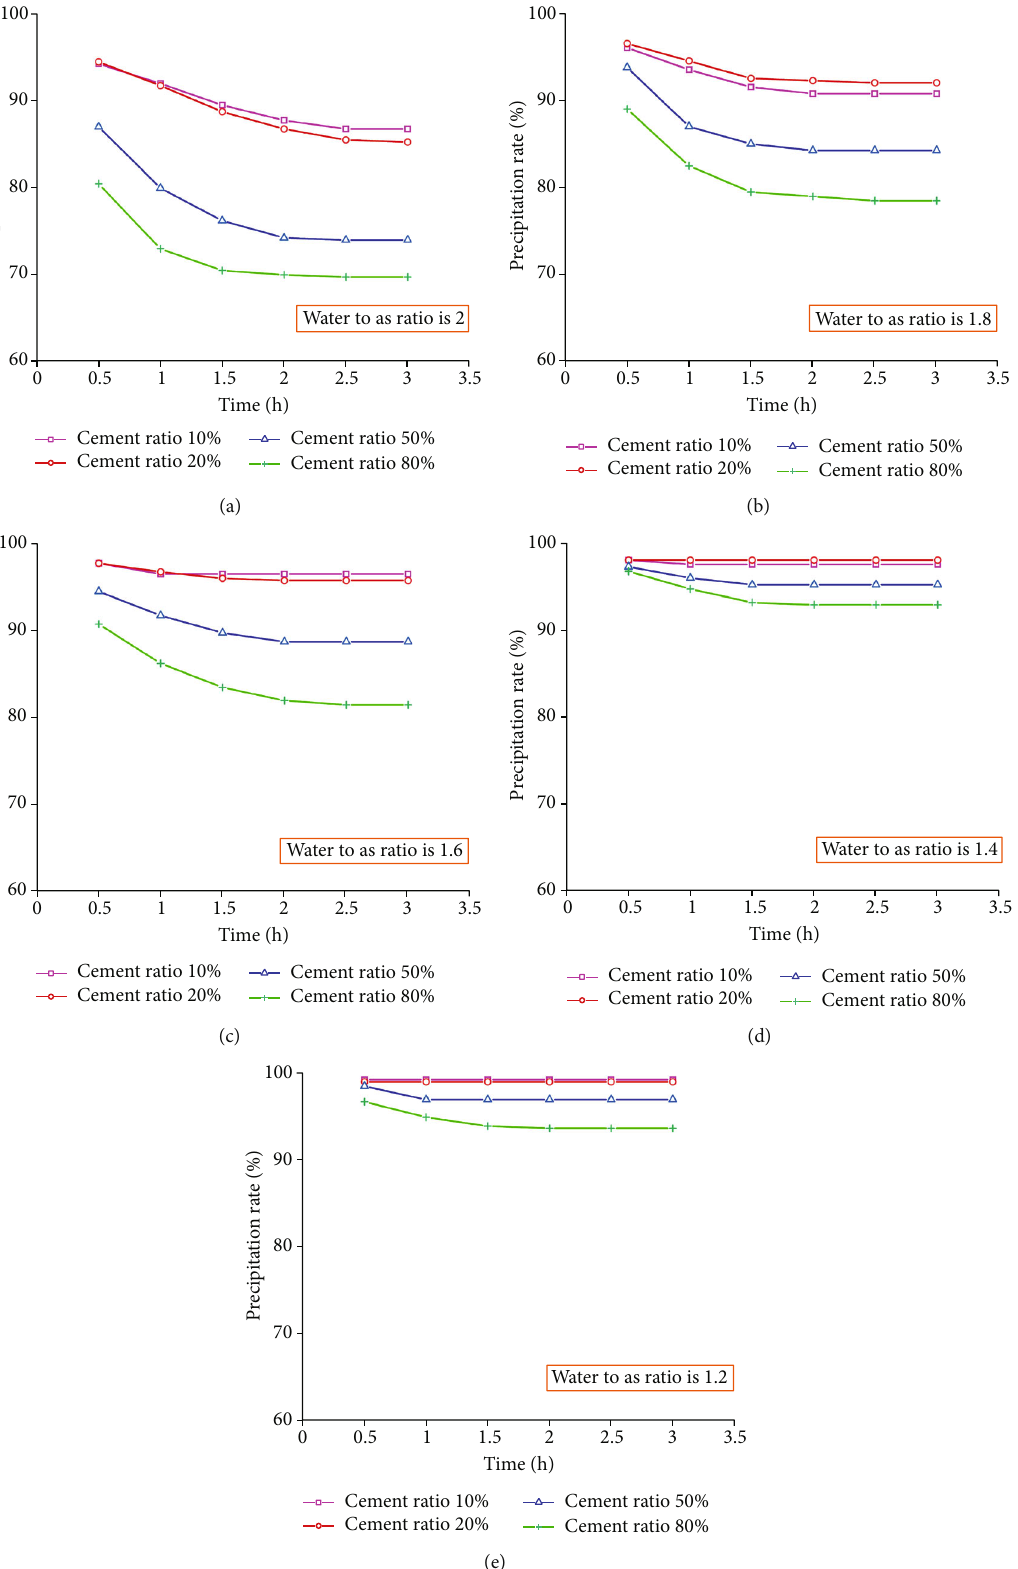
Figure 4: Average slurry precipitation rate corresponding to di ff erent water-ash ratios. (a) Water-ash ratio of 2; (b) water-ash ratio of 1.8; (c) water-ash ratio of 1.6; (d) water-ash ratio of 1.4; (e) water-ash ratio of